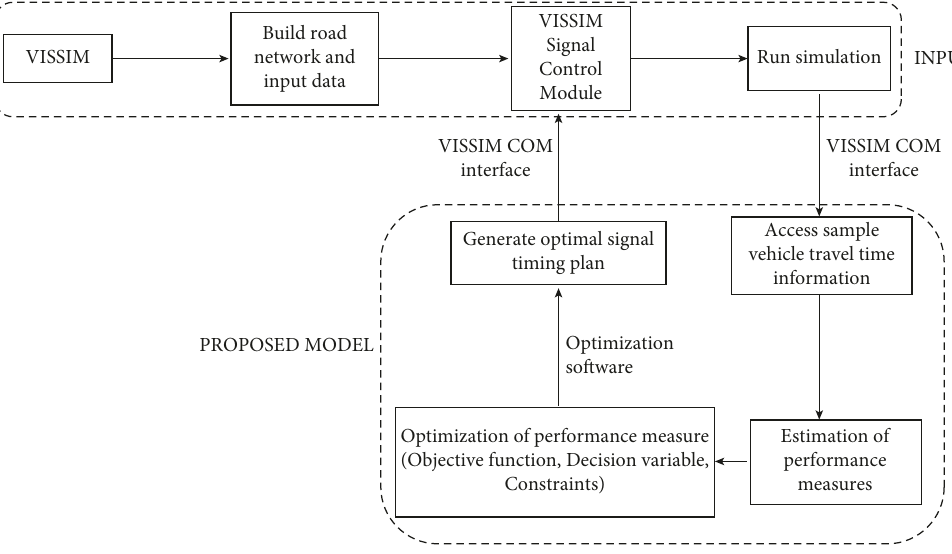
Figure 7: Flowchart on model implementation through